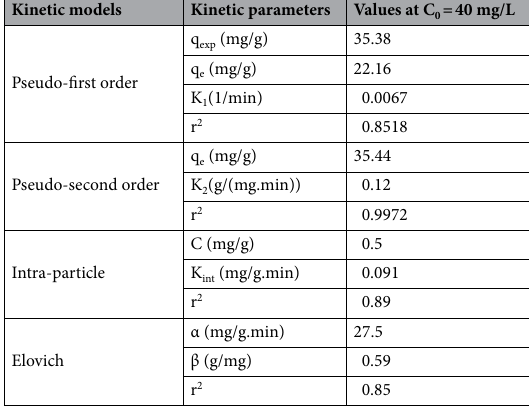
Table 1. Kinetic parameters for the removal of Cd by the MBA nano-hybrid. (pH = 7.0, [MBA] 0 = 1.0 g/L, temperature = 25 °C, contact time = 60 min).